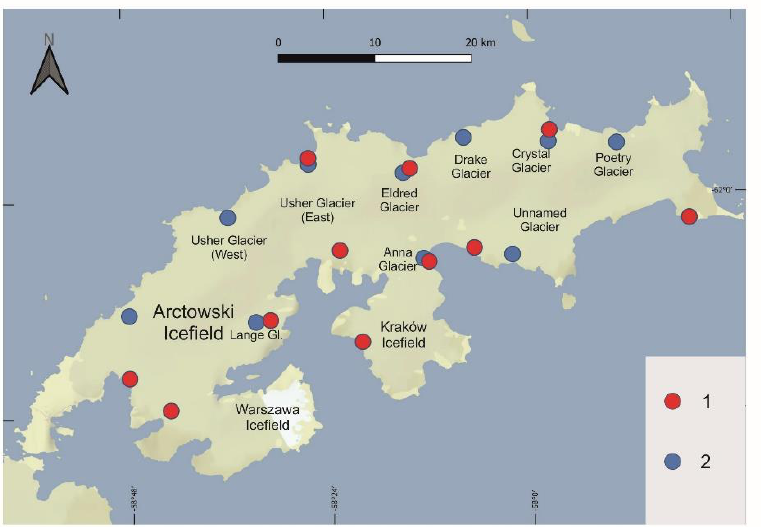
Figure 14. Places characterized by high ice velocities. (1)—The areas of high movement rates (more than 30 cm per day) calculated on basis of available tandem pair (DInSAR) from 23/24 October 1995. Reused with permission from Moll et al. [99], published by IEEE, 2006; and (2)—the areas of high average ice velocities (more than 200 m per year) calculated on basis ALOS PALSAR imagery between January 2008 and January 2011. Adapted with permission from Osmanoğlu et al. [23], published by Cambridge University Press, 2013.